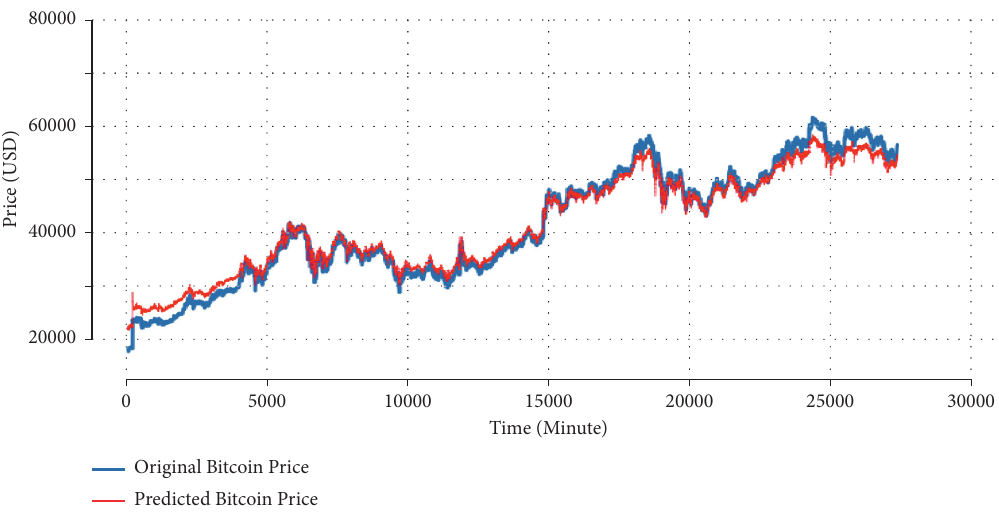
Figure 12: Prediction results via SVR-TI-rVMF model. Table 8: Evaluation metrics of SVR-TI, SVR-rVMF, and